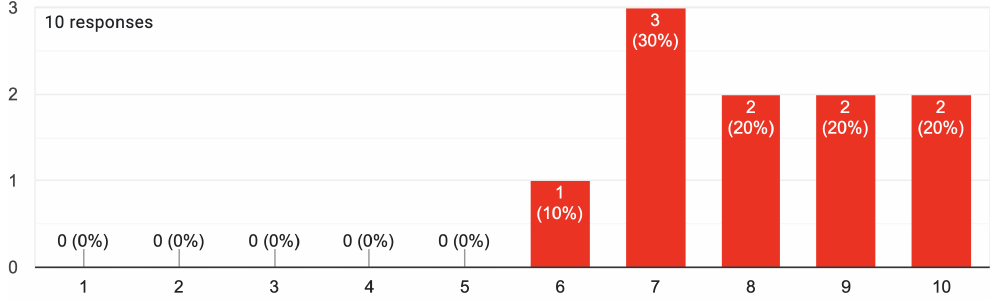
Figure 11. Feedback collected from students: on a scale of 1–10 with 1 being not engaging at all